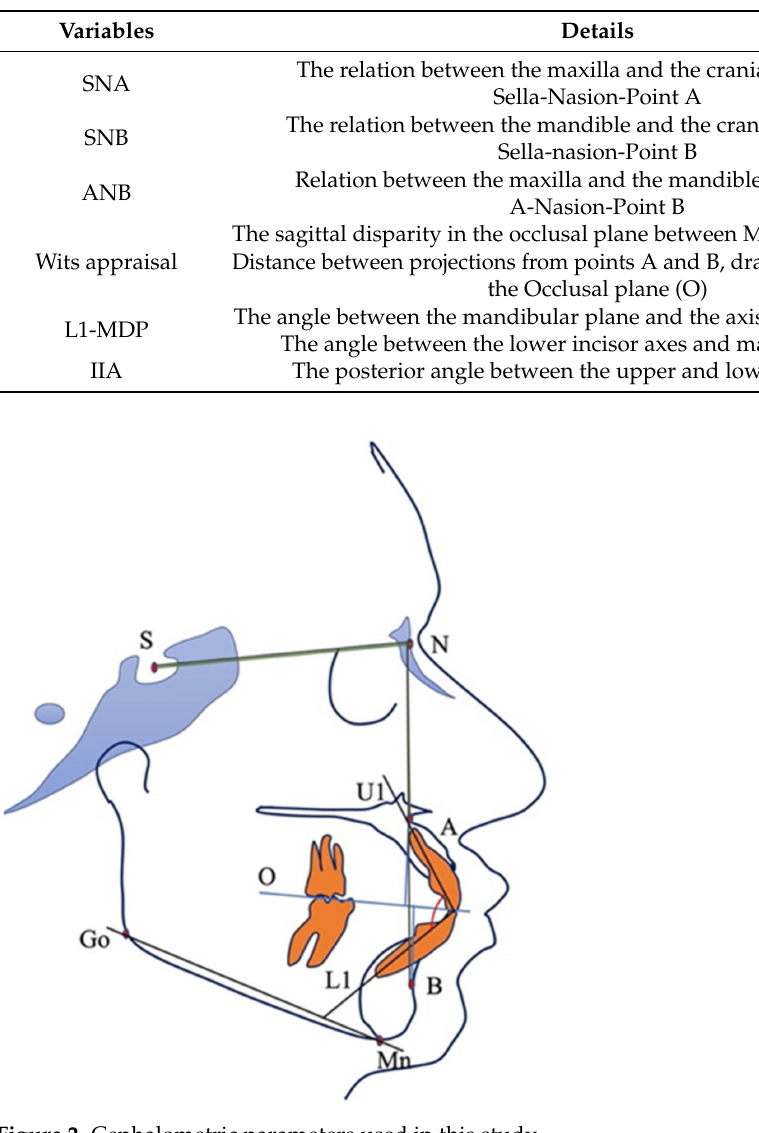
Figure 2. Cephalometric parameters used in this